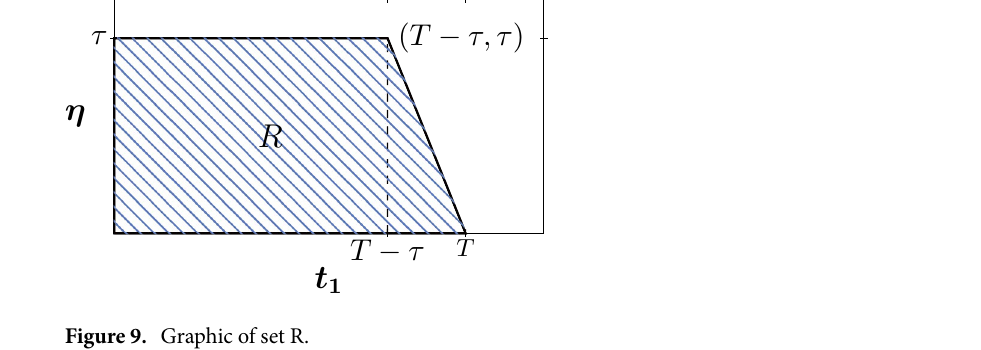
Figure 9. Graphic of set